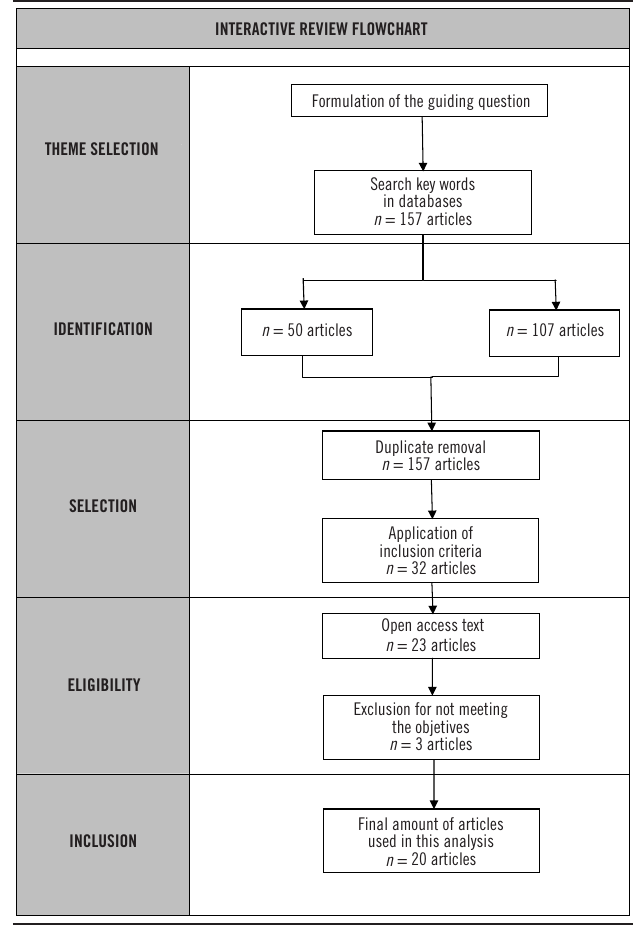
FIGURE – Flowchart of search and selection steps of the analyzed articles